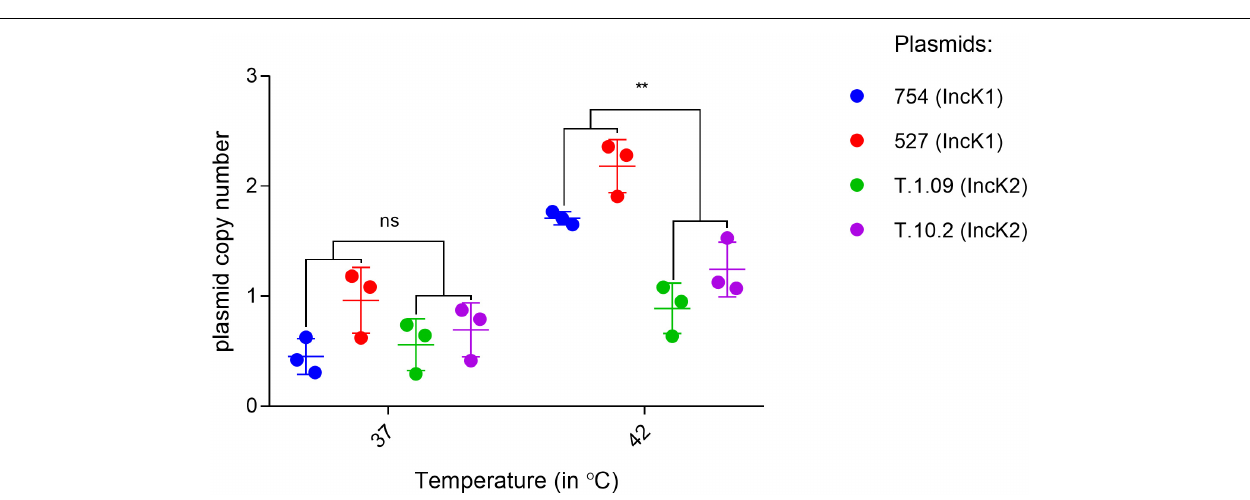
FIGURE 2 | IncK1 and IncK2 plasmid copy numbers at 37 and 42 ◦ C. All the measurements were performed in triplicate. Bars depict the mean and standard deviation. ∗∗ depict statistical significance ( p =